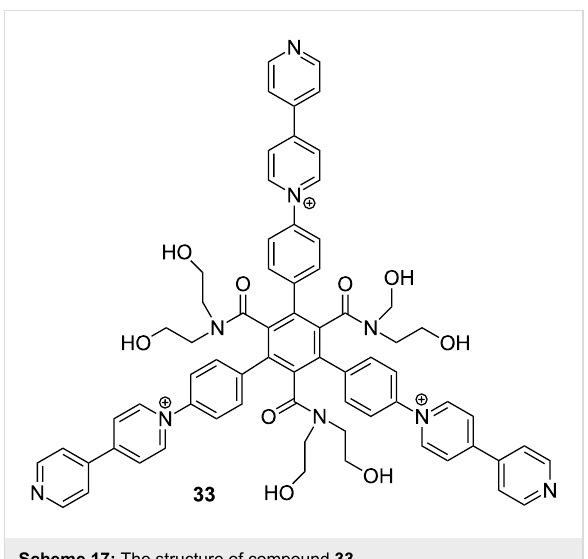
Scheme 17: The structure of compound 33